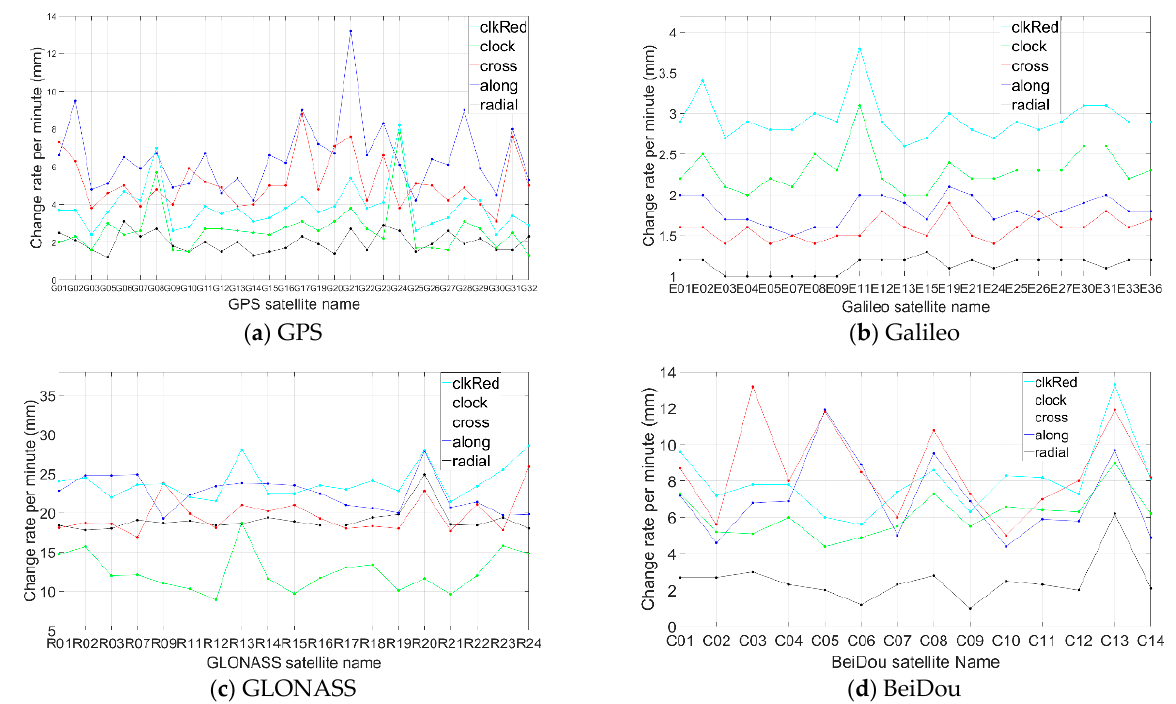
Figure 6. Average change per minute of orbital and clock corrections ( a : GPS, b : Galileo, c : GLONASS, d : BeiDou). In terms of the clock correction, the change rates of GPS and Galileo were similar, both slightly over 2 mm/min, and it was around 6 mm/min for BeiDou, while it was more than 10mm/min for GLONASS. In Figure 6, the “clkRed” curve shows the combined change of radial and clock corrections. The change rate of Galileo was the smallest, at around 3 mm/min; for GPS, it was around 4 mm/min; for BeiDou, it was around 8 mm/min; and for GLONASS, it was more than 20 mm/min. 3. Improving the Performance of the Time-Relative Method Based on the analysis of the main error sources in Section 2, the following measures are proposed to improve the performance of the time-relative positioning: